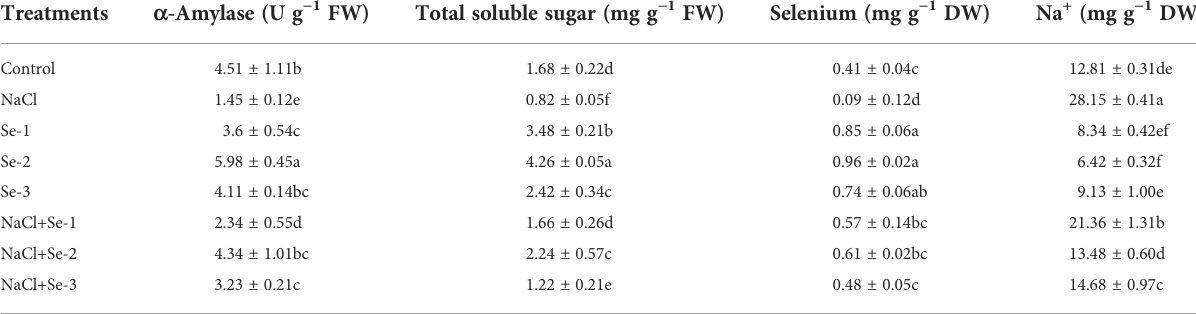
Data presented are the mean ± SD of fi ve replications. Different letters denote signi fi cant differences between treatments at p ≤ 0.05. NaCl = 200 mM NaCl; Se-1 = 75 m mo L − 1 Se; Se- 2 = 100 m mo L − 1 Se; Se-3 = 125 m mo L − 1 Se. FW, fresh weight; DW, dry